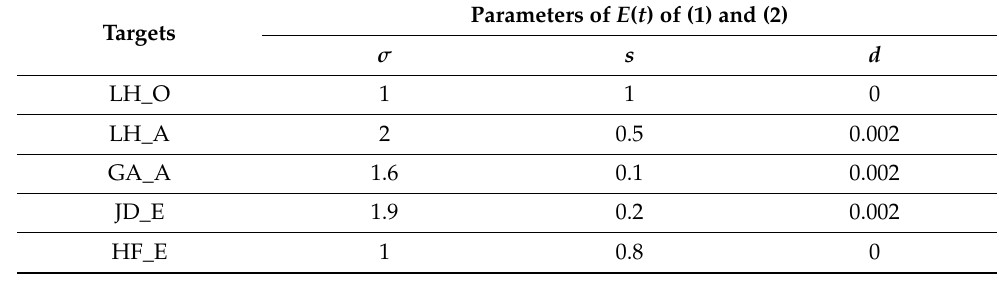
Table 6. The parameters of an emotional intensity over time E ( t ) of (1) and (2); LH of objects (LH_O), LH of agents (LH_A), GA of agents (GA_A), and JD of events (JD_E) in the experiments. Parameters of E ( t ) of (1) and (2) Targets